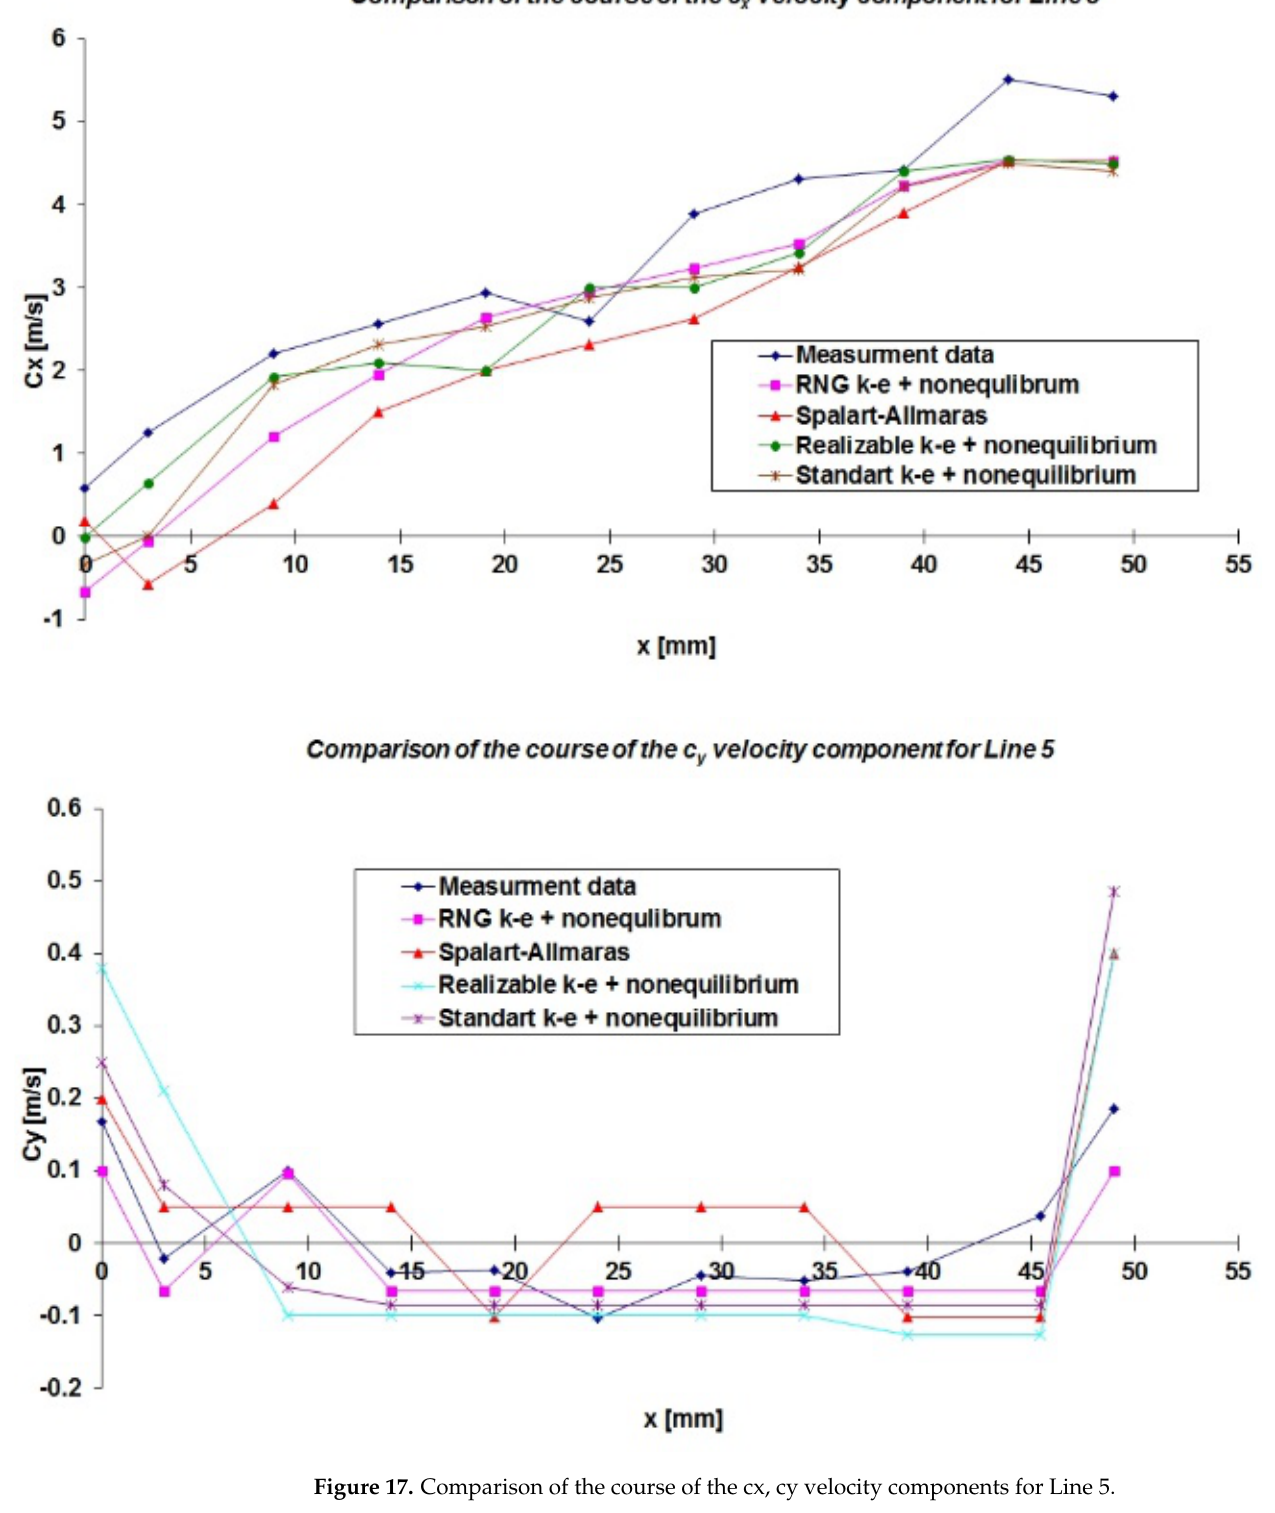
Figure 17. Comparison of the course of the cx, cy velocity components for Line 5.